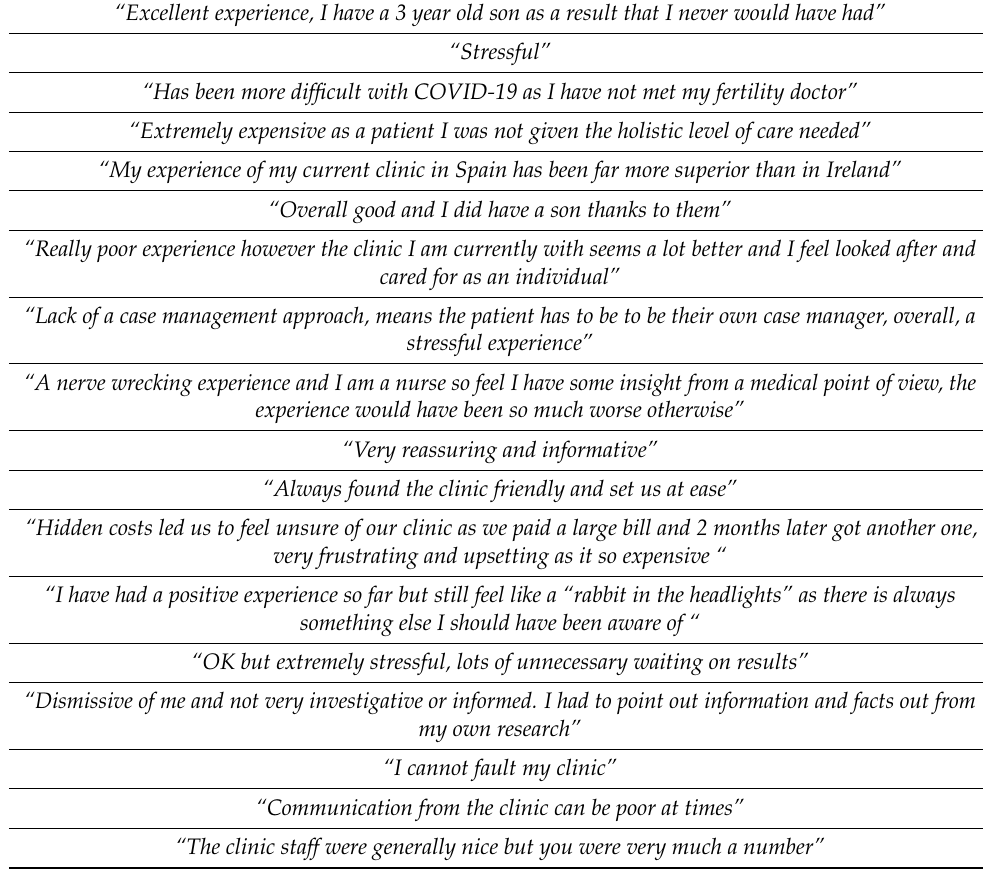
Table 4. Summary of some responses about participants’ experiences of the overall